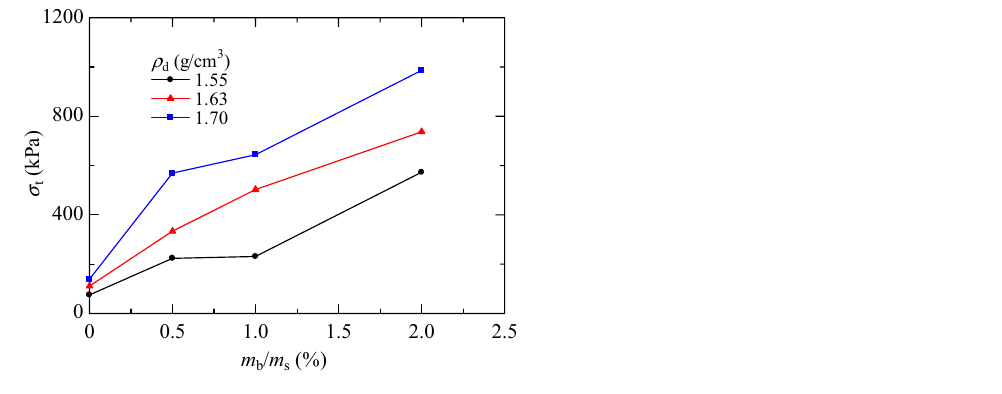
Figure 7. Relationship between splitting tensile strength and XG